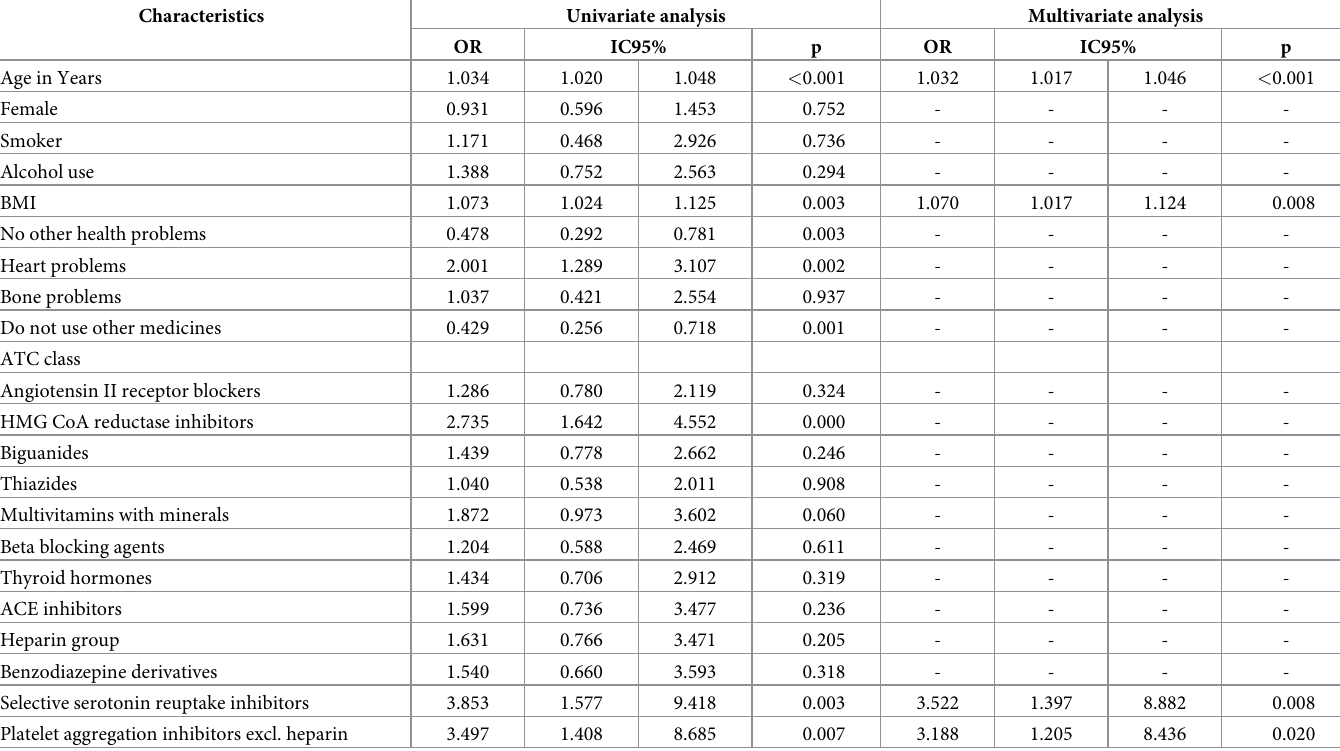
Table 4. Multivariate model by logistic regression of factors associated with long-term use of PPIs ( > 3 years).